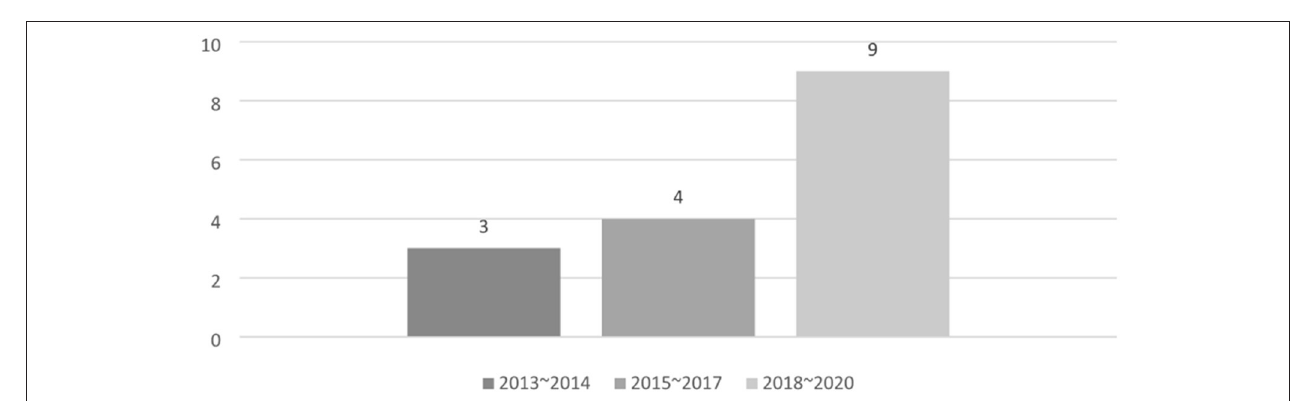
FIGURE 2 | Number of papers by